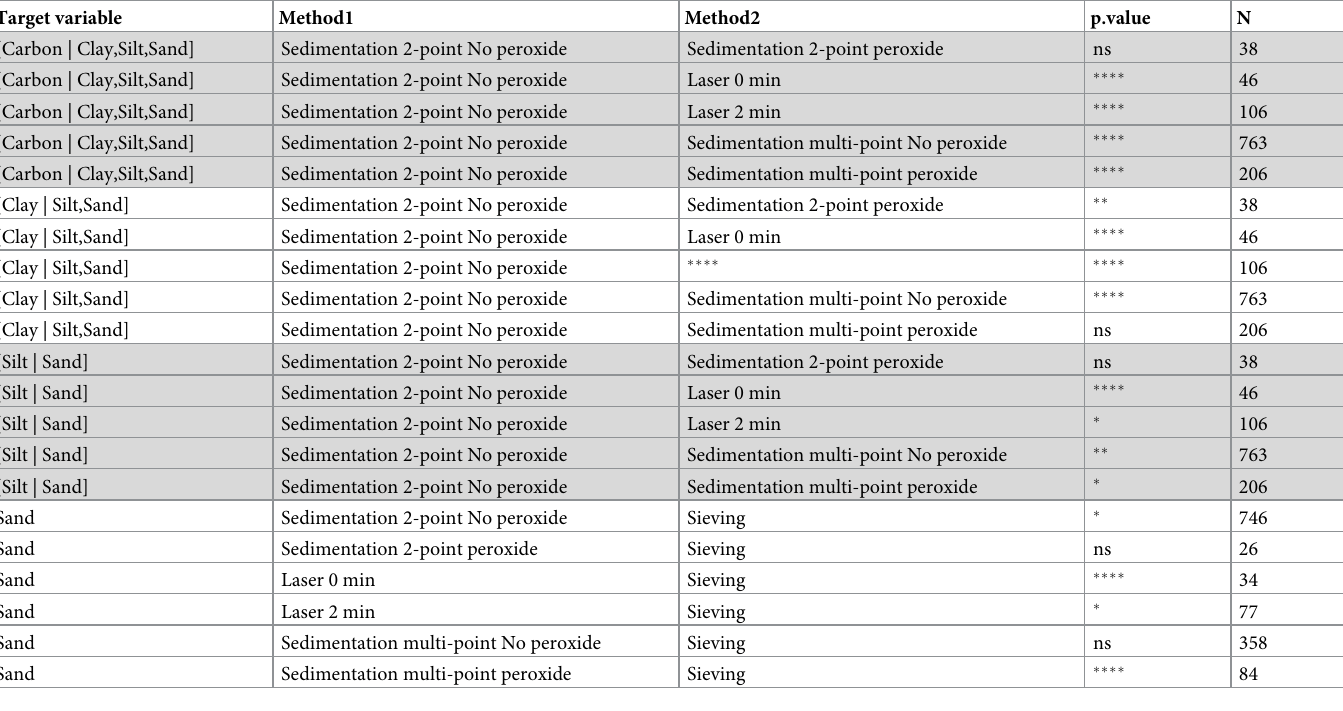
Table 2. Comparison of methods (method1 minus method2) using paired t-test and confidence intervals (p �